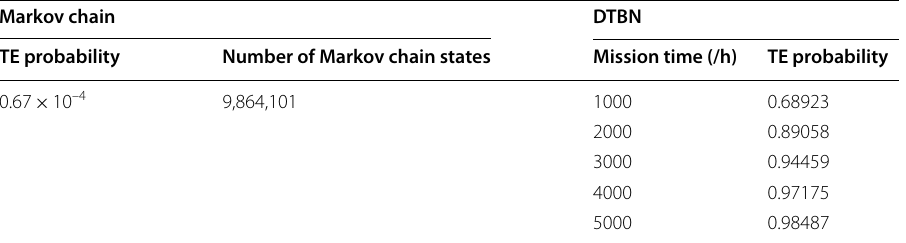
Table 2 TE probability estimated by BN-based method and MC-based Markov chain DTBN TE probability Number of Markov chain states Mission time (/h) TE